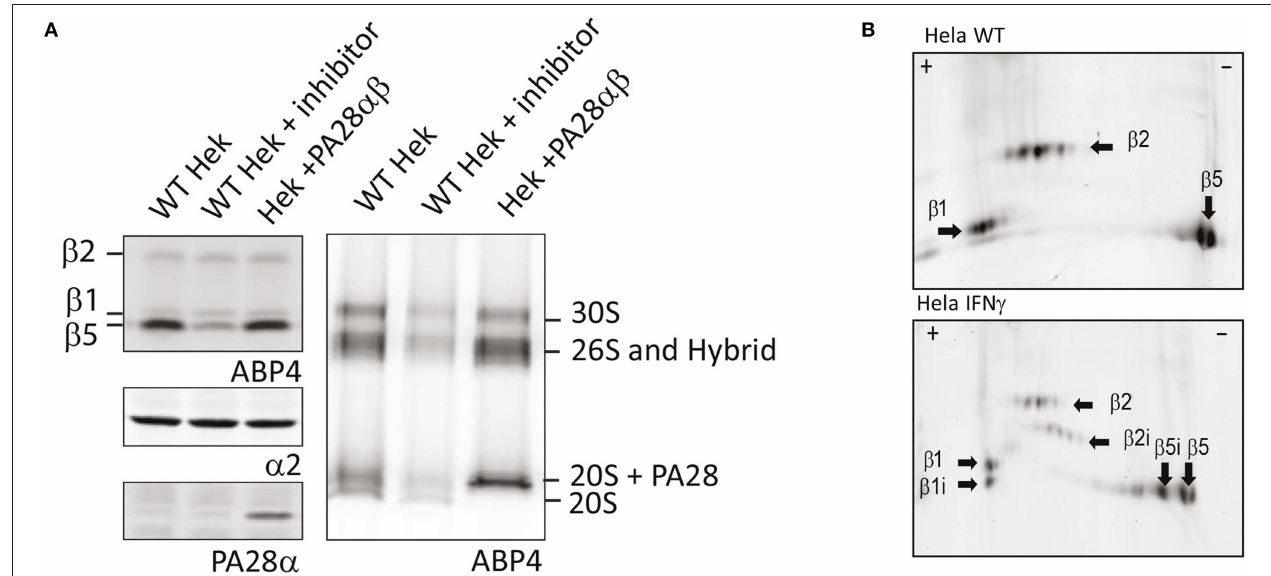
FIGURE 4 | Proteasome activity labeling in cell lysates. (A) Activity labeling of individual subunits vs. proteasome complexes. Control cell lysates, lysates pre-incubated with MG132 and lysates of cells overexpressing PA28 αβ were incubated with ABP4 and loaded on SDS-PAGE (left) or 3–12% native gels (right). Wet gels slabs were scanned for activity labeling and intensities were determined using AlphaEase software. After transfer to membranes, anti- α 2 antibodies were used to identify proteasome complexes and PA28 α antibodies were used to show PA28 over-expression. Expression of PA28 αβ induced a shift in proteasome activity toward PA28-capped proteasomes. (B) Visualizing activity of constitutive and immunosubunits on 2D gels. Cell lysates of control Hela cells and IFN- γ stimulated HeLa cells were incubated with ABP4 , subjected to pH 3–10 strips to separate proteins in the first dimension. Subsequently, proteins were separated by size in the second dimension on a 12% SDS-PAGE gel. Fluorescence scanning revealed the labeled subunits. Unlike visualization on a one dimention SDS gel, the activity of all six catalytic subunits could be visualized